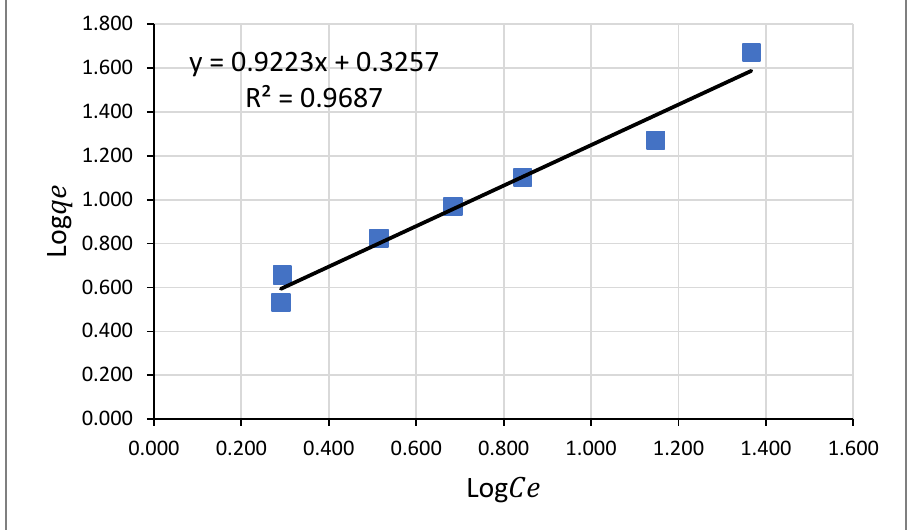
Figure 11. Freundlich Adsorption Isotherm Model for Lead.